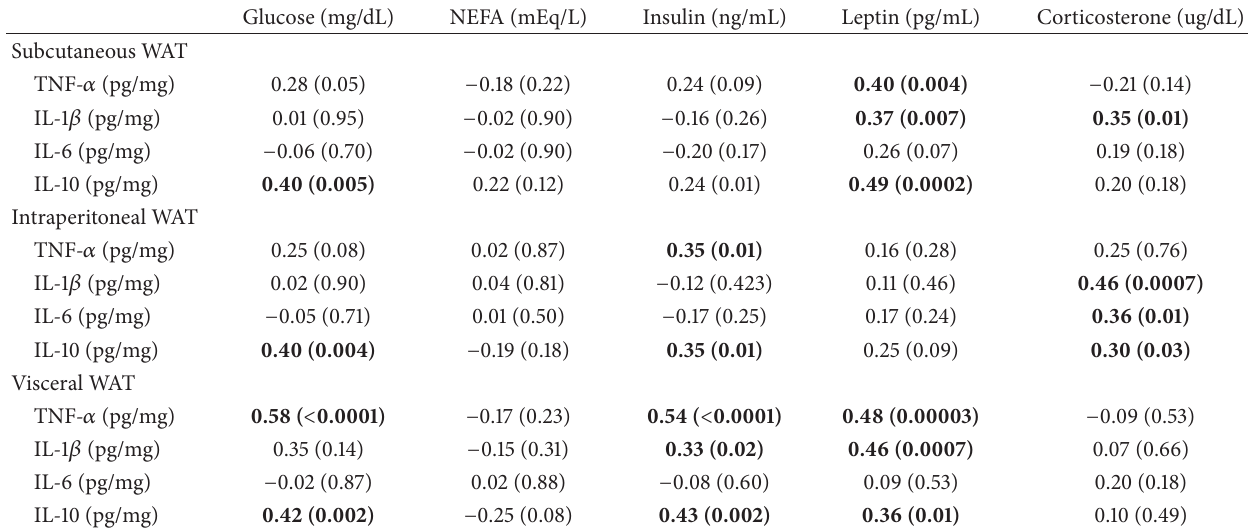
Table 3: Correlational relationships between biomarkers of energy status and cytokine expression in WAT. Correlations between blood plasma concentrations and WAT cytokine concentrations for all rats ( 𝑁 = 50 ). Values are expressed as the Pearson correlation constant 𝑟 followed by the ( 𝑝